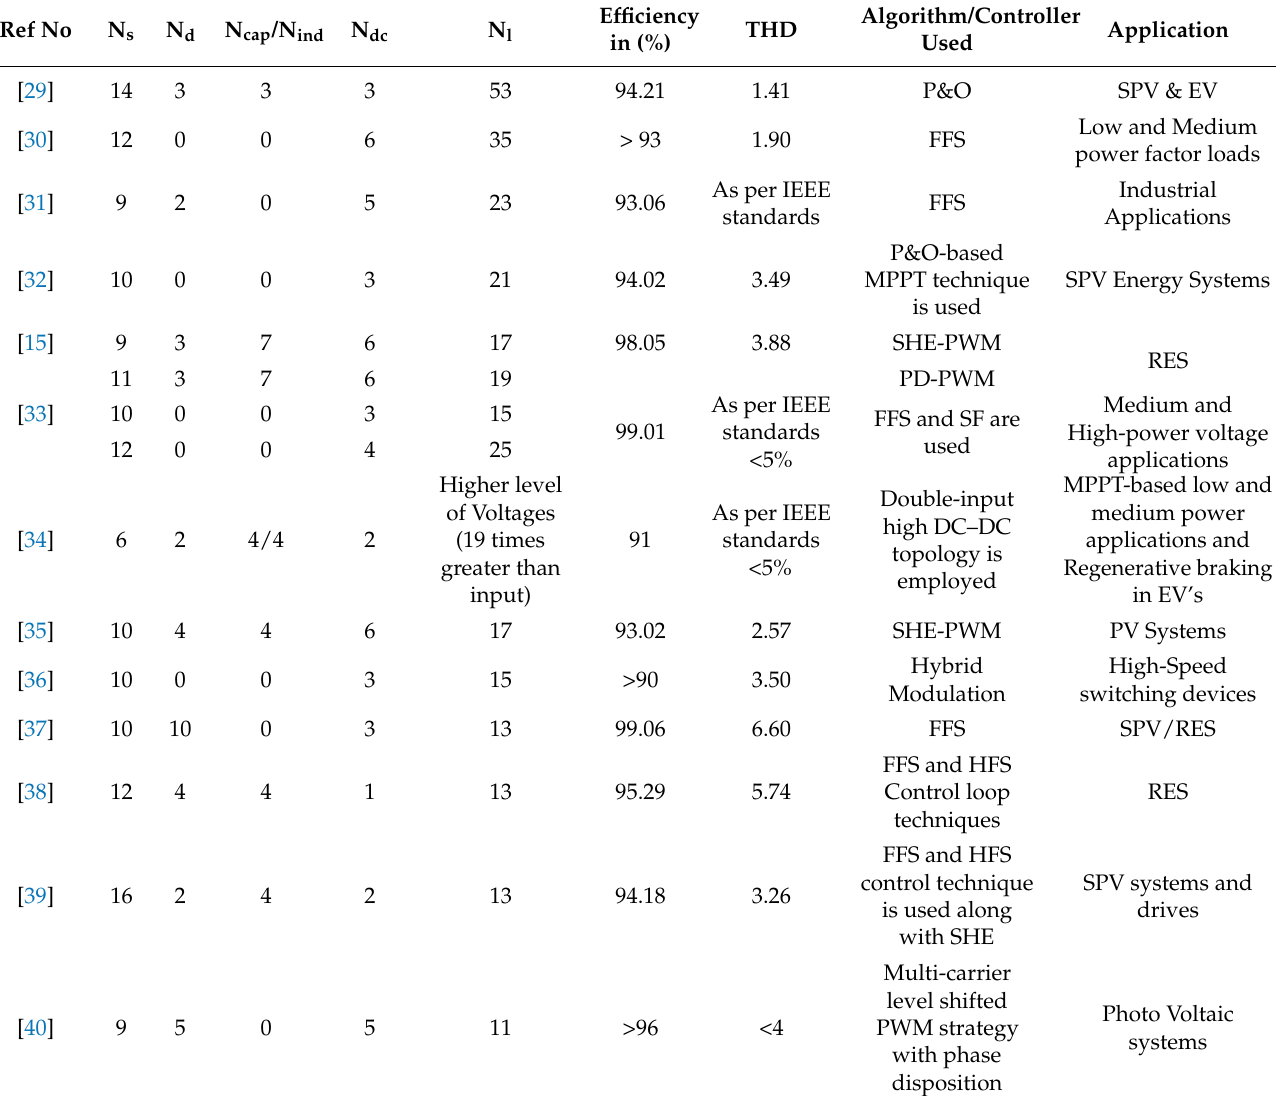
Table 2. Comparative analysis for different converters representing their switch counts, diodes, capac- itors, inductors, DC source counts, number of levels generated, efficiency, THD, algorithm/controller used, and their applications. Algorithm/Controller